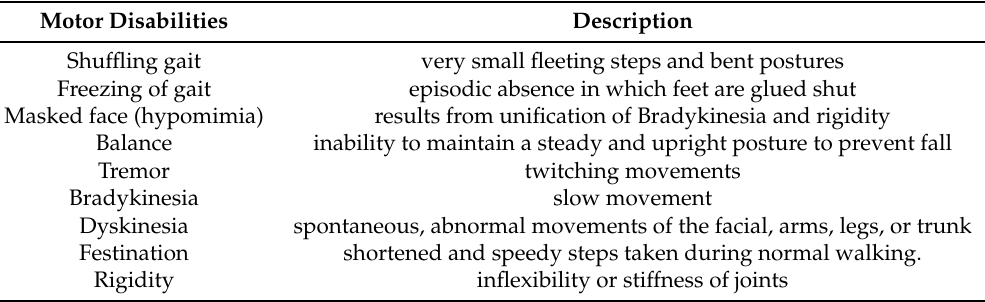
Table 6. Motor disabilities that affects Quality of Life